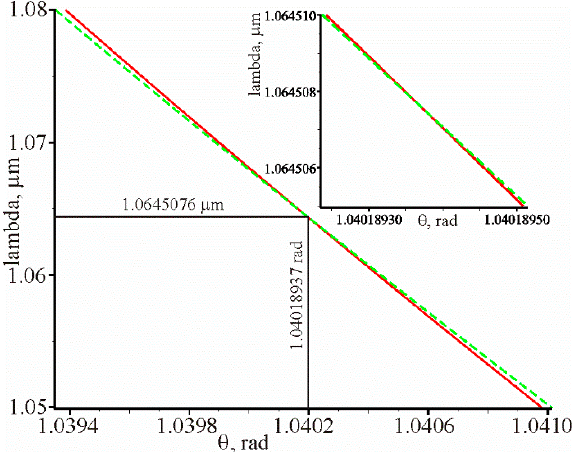
Figure 4. Graphical dependencies Re ( r ( θ , λ )) = 0 (solid line) and Im ( r ( θ , λ )) = 0 (dotted line) at the following parameters: d = 52.69 nm, = 1.56, n a = 1.3242. The intersection of the solid and dotted curves determines the θ and λ , at which the reflection coe ffi cient is equal to R = 2.6 × 10 − 14 . The inset shows parts of the intersected curves on a larger